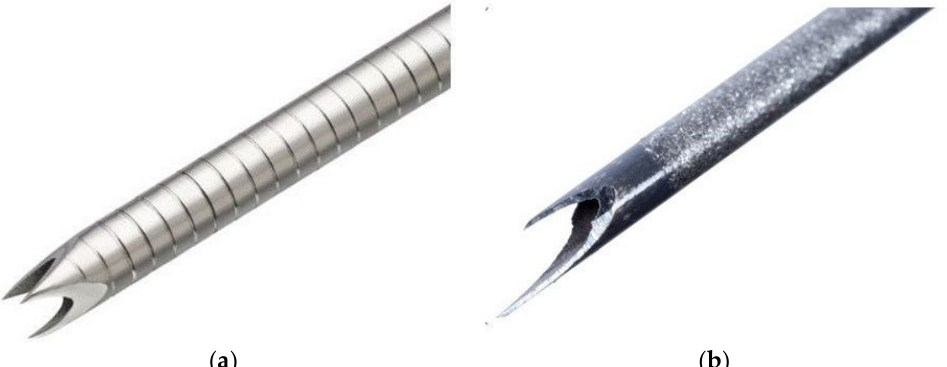
Figure 1. Photographs of ( a ) a 22G Franseen needle (Acquire TM ) and ( b ) a 22G Fork-tip needle